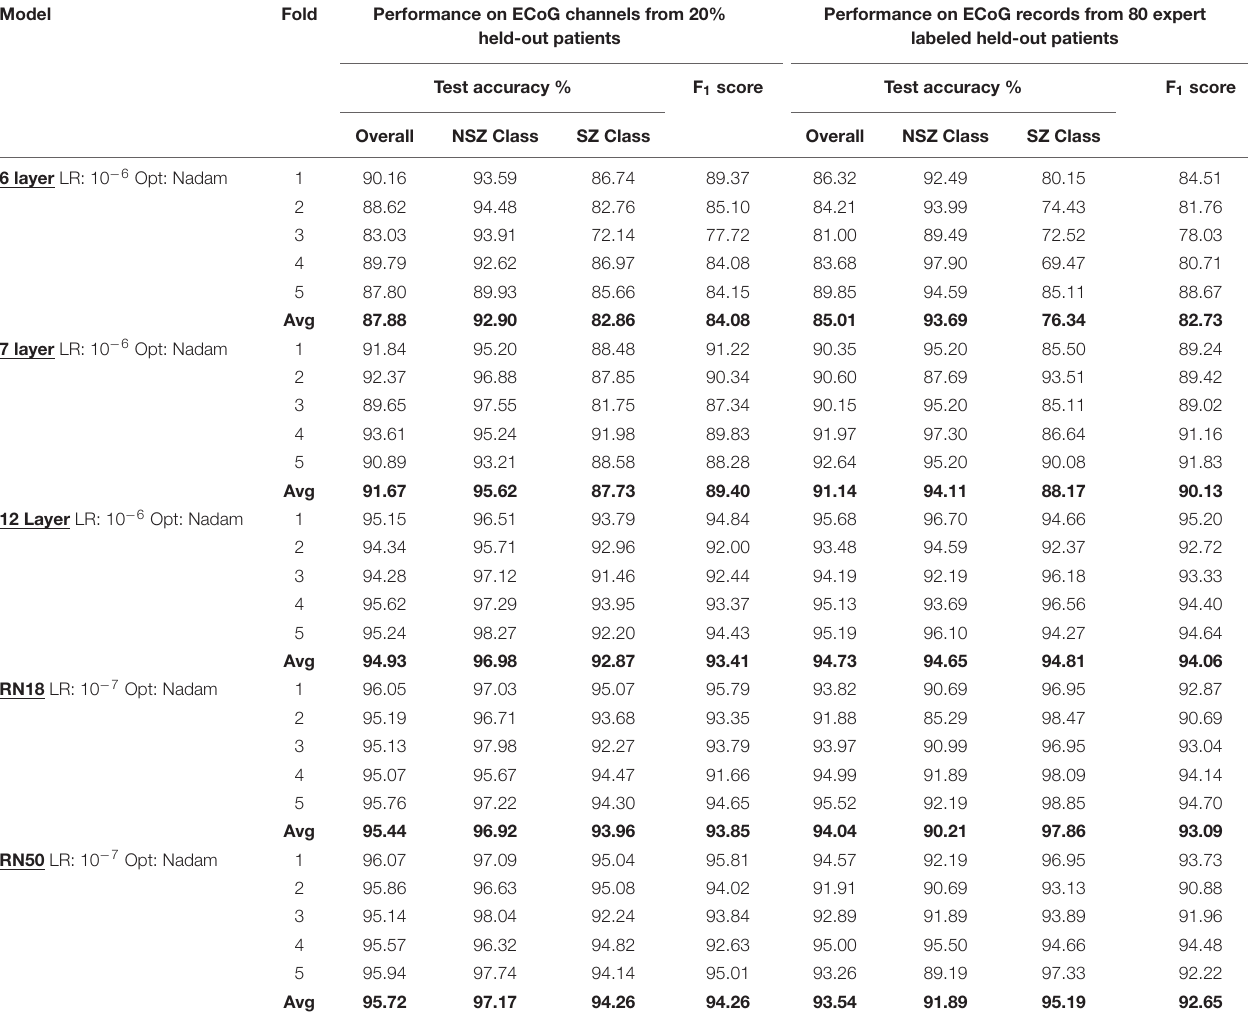
TABLE 2 | Test performance on held-out ECoG channels and expert labeled ECoG records. Model Fold Performance on ECoG channels from 20%